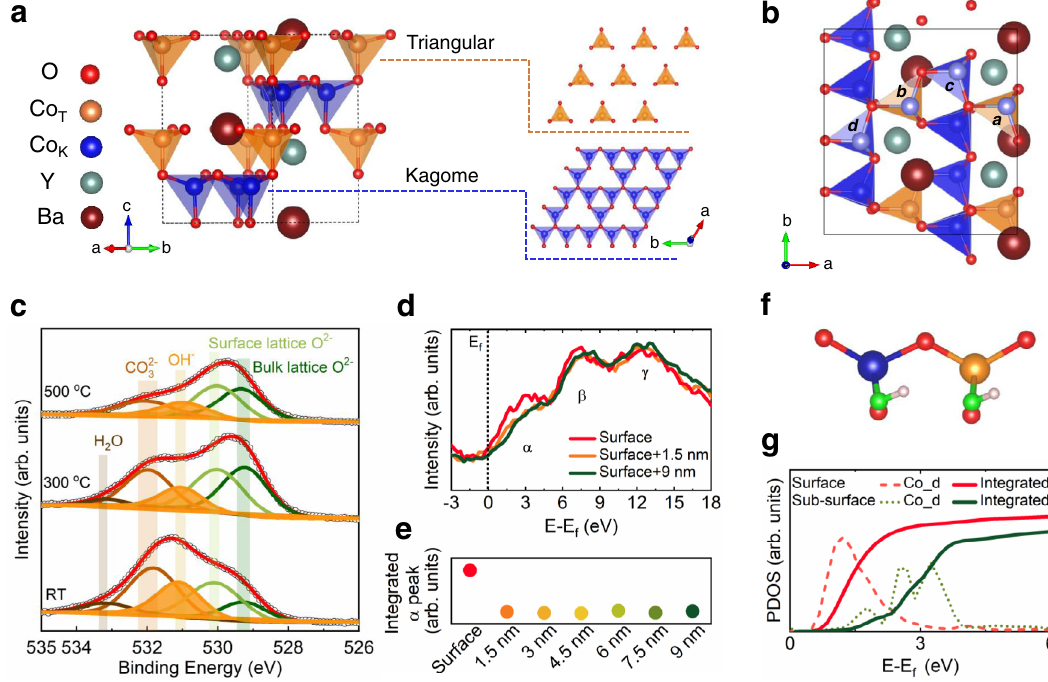
Fig. 1 | Cobalt tetrahedra over YBC4 surface.a CrystalstructureofYBC4 and the arrangements of corner-shared CoO4 tetrahedra in the Triangular layer and the Kagome layer. b The top view of the YBaCo 4 O 7 (110) facet with tri-oxygen- coordinated cobalt (marked in orchid). c O 1s core spectra from temperature- dependent XPS of an as-prepared YBC4 sample. d O K-edge EELS spectra from the sub-surface (~9nm and ~1.5nm) and the surface of YBC4. All spectraare aligned to Fermi energy ( E f ) with 0eV. e Extracted intensities of α peaks from sub-surface to